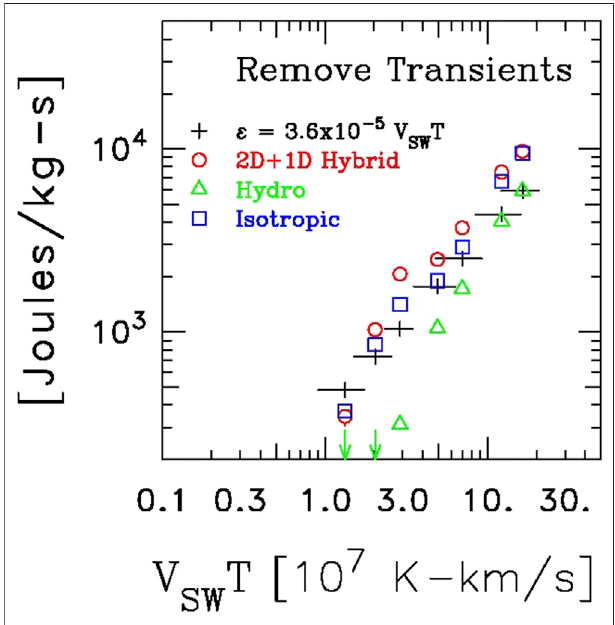
FIGURE 3 | Application of Eqs (9) and (10) years of data from the AdvancedCompositionExplorer(ACE)spacecraft[ReproducedfromStawarz et al.